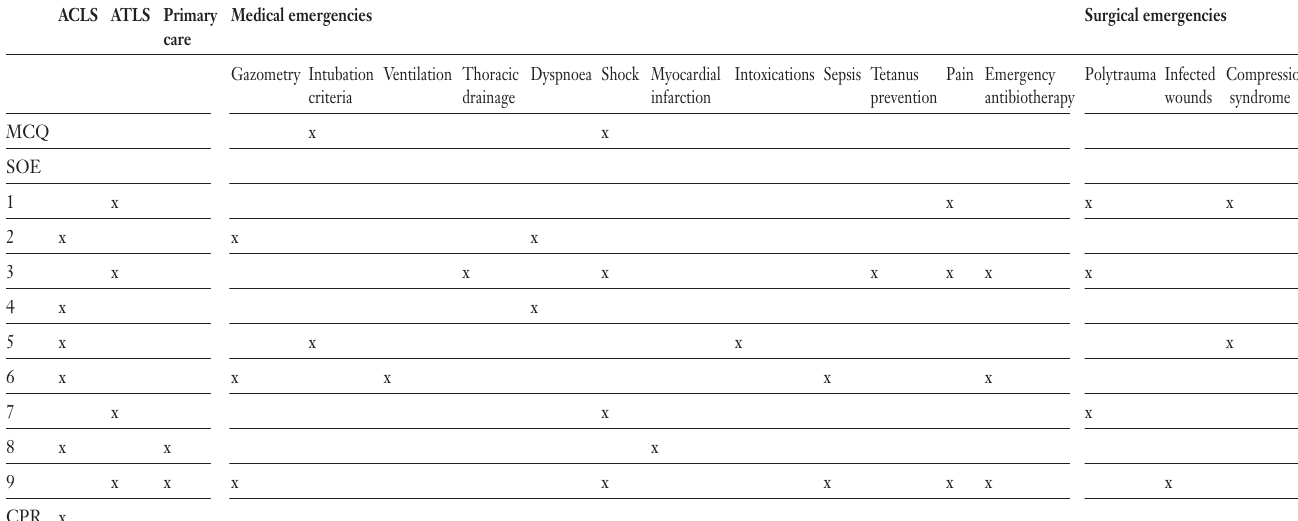
Type of emergencies assessed in the Multiple-choice questions (MCQ), Standardized Oral Exam (SOE), and the Cardio-pulmonary resuscitation (CPR) examinations. ACLS ATLS Primary Medical